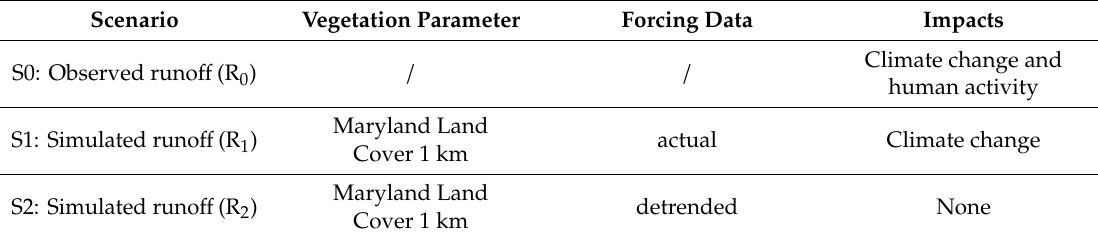
Table 2. Experiment design and simulation scenarios used to detect the impact of climate change and human activity. Scenario Vegetation Parameter Forcing Data